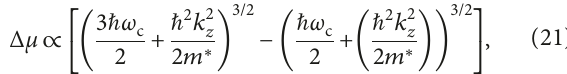
21kOe, where the (cid:29) H and ε H , (cid:25) ⊥